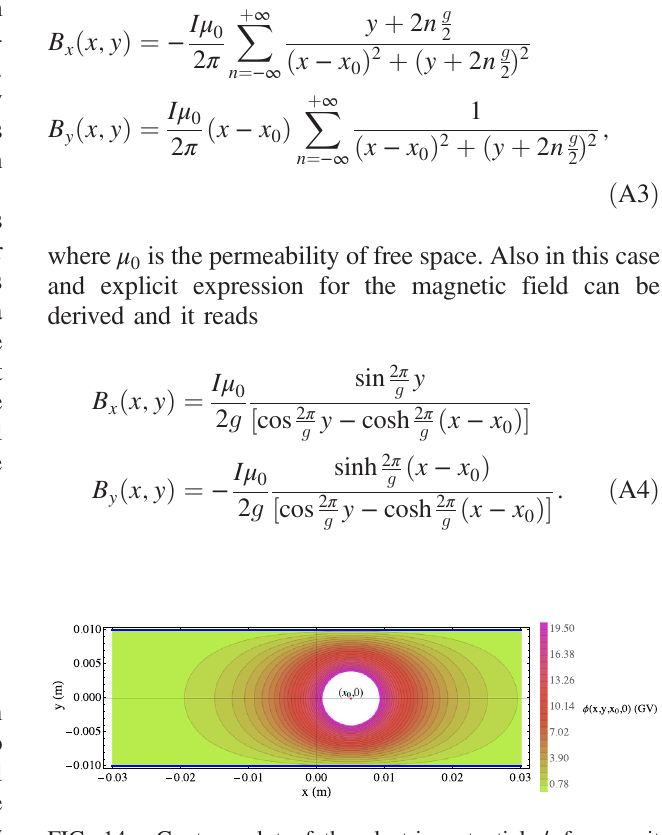
FIG. 14. Contour plot of the electric potential ϕ for a unit charge density located in ð x 0 ; 0 Þ . The boundary surfaces are shown in